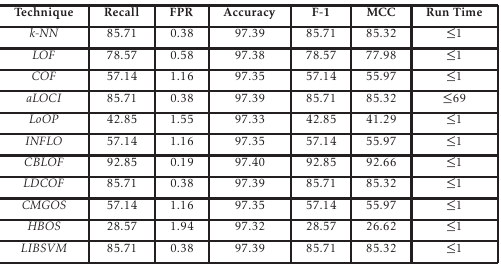
Table 5. Performance of Anomaly Detection Techniques